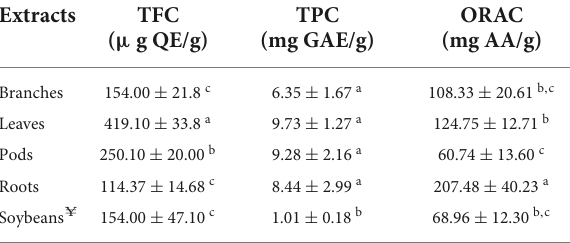
TABLE 4 Total content of flavonoids (TFC) and phenolics (TPC), as well as antioxidant capacity (ORAC) of the individual extracts of soy by-products (i.e., branches, leaves, pods, and roots) and soybeans resulted from pressurized choline chloride/citric acid/water (1:1:11) at 120 ◦ C, 100 bar, and 20 min of